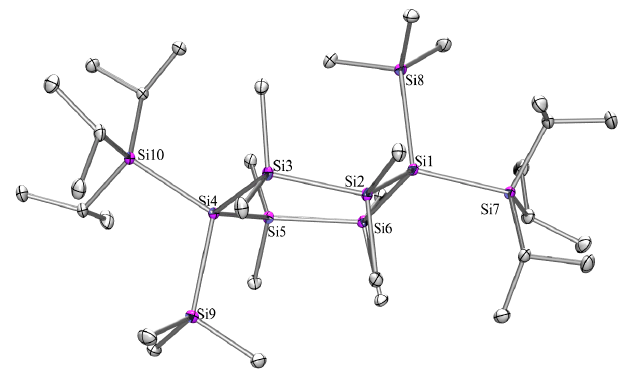
Figure 19. Crystal structure of 21b . Thermal ellipsoids are represented at the 30% level and hydrogen atoms have been omitted for clarity (bond lengths in Å, angles in deg). Si(1)-Si(2) 2.3613(7), Si(1)-Si(6) 2.3714(7), Si(1)-Si(8) 2.3734(8), Si(1)-Si(7) 2.4033(7), Si(2)-C(1) 1.8900(17), Si(2)-Si(3) 2.3603(7),